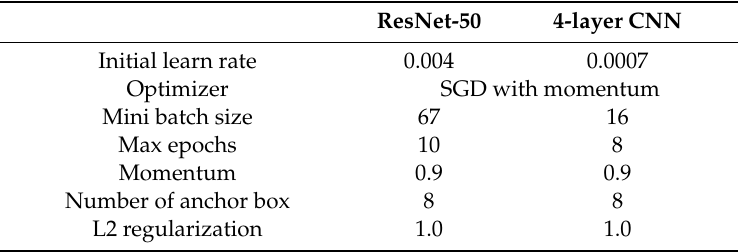
Figure 6. Training for the feature extractor for YOLO v2 detector. The input images were tree or non-tree images [ a ]. Pre-trained network and 4-layer CNN [ b ] were trained with the images to classify into tree or non-tree [ c ]. Then, the weights of the networks were used for the feature extractor in the YOLO network. Table 1. Parameters for binary classification of tree / non-tree images. SGD in the optimizer stands for stochastic gradient decent.